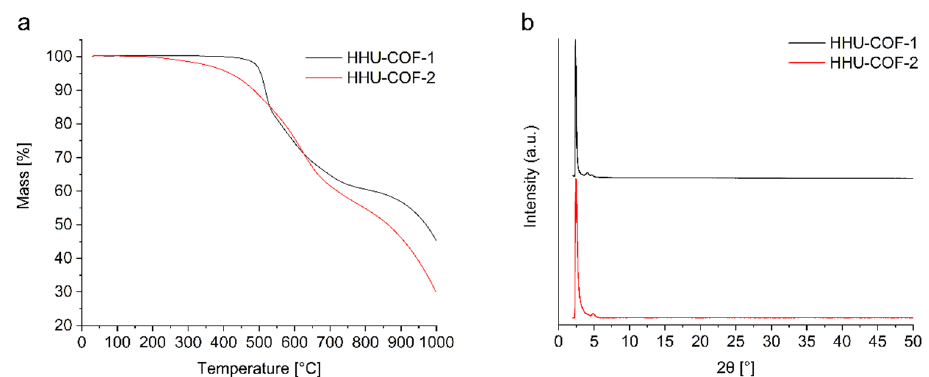
Figure 5. ( a ) TGA curves acquired under nitrogen atmosphere with a heating rate of 5 K/min and ( b ) PXRD pattern of HHU-COF-1 and HHU-COF-2. The first derivative of the TGA curves is given in Figure S15.